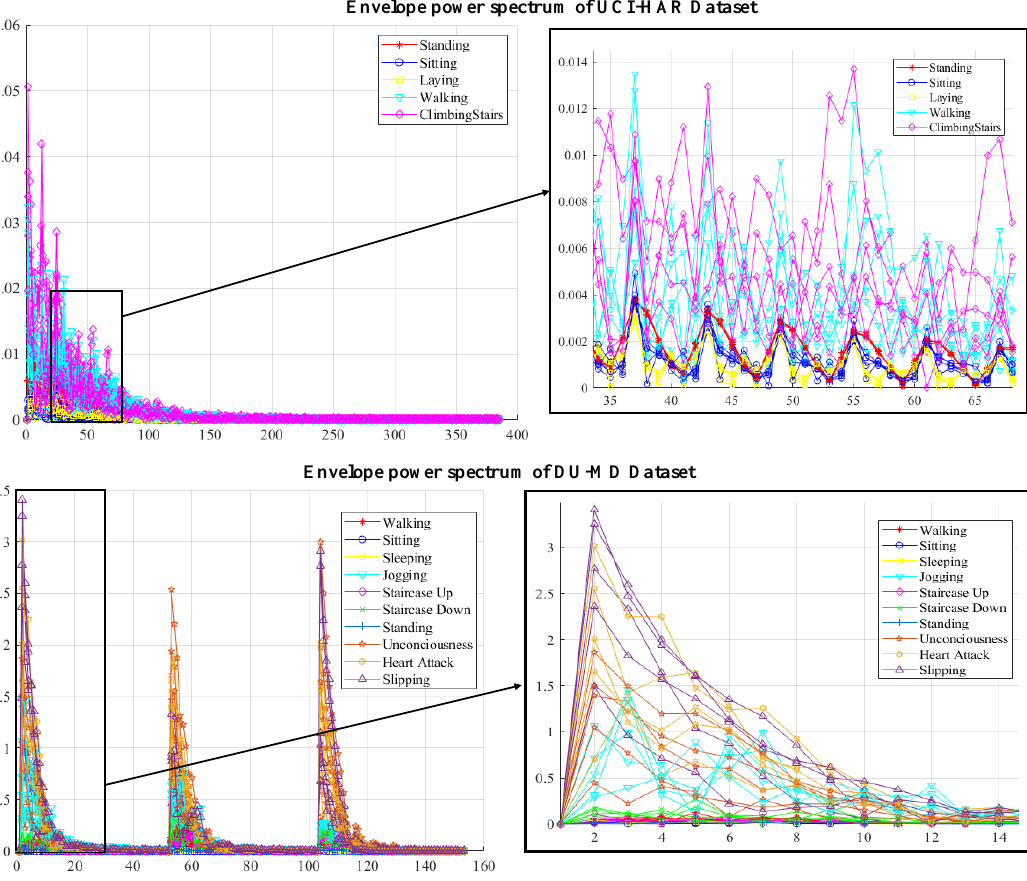
Figure 8. Signal impulse of human